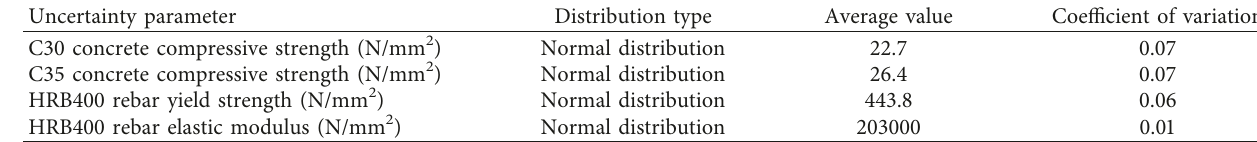
Table 3: Statistics of structural uncertainty parameter.